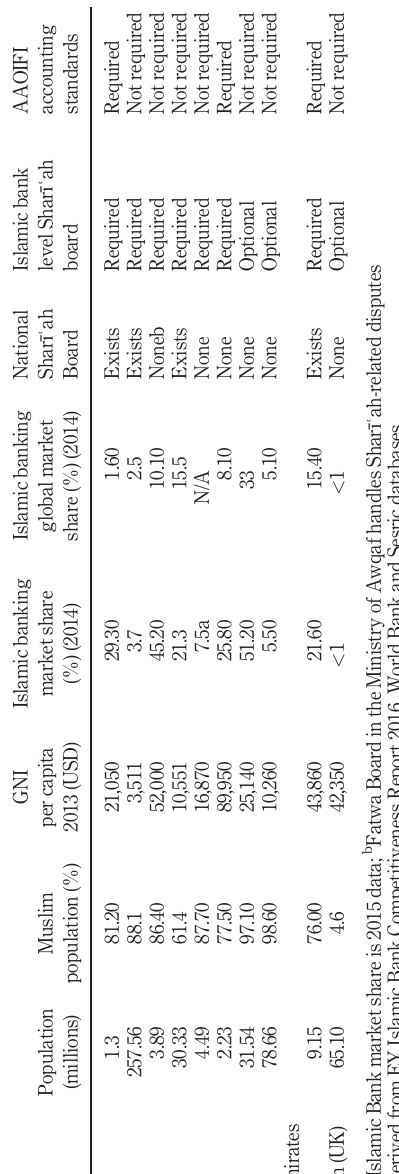
Table I. Basic statistics on Islamic